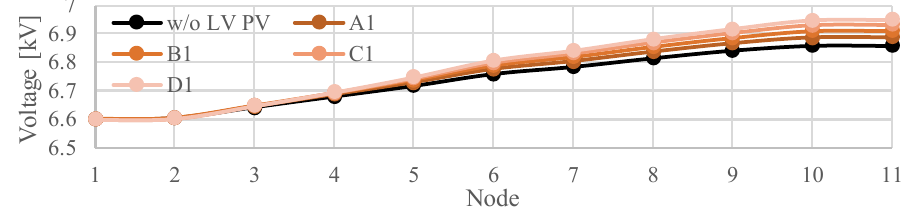
Figure 16. Voltage profile in another MV distribution feeder (power factor is set to 1.00).